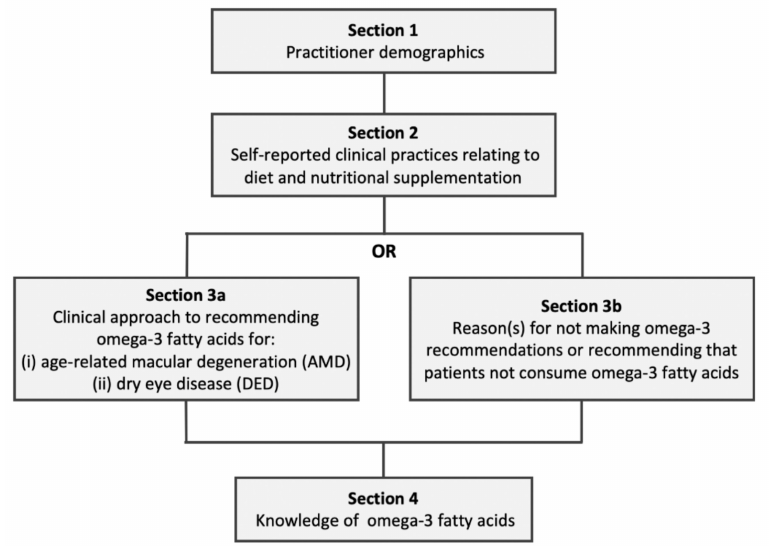
Figure 1. Survey